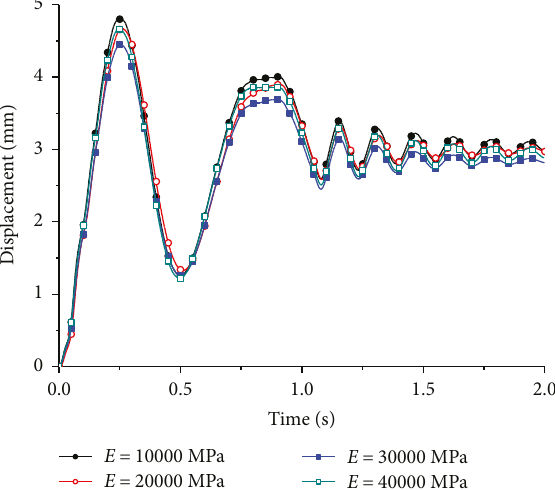
Figure 26: Vertical displacement of launch canister top at di ff erent elastic